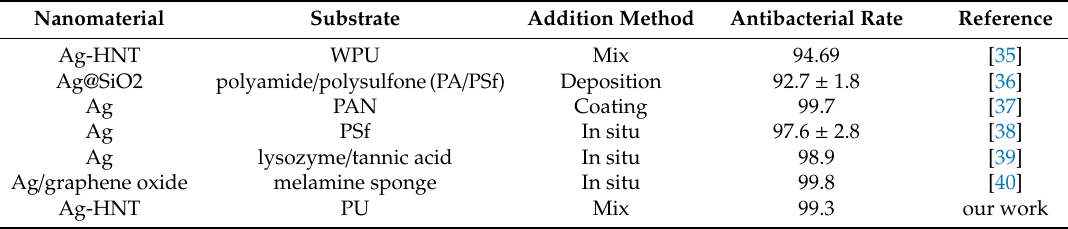
Table 7. The antibacterial rate of E. coli . in the literature and our